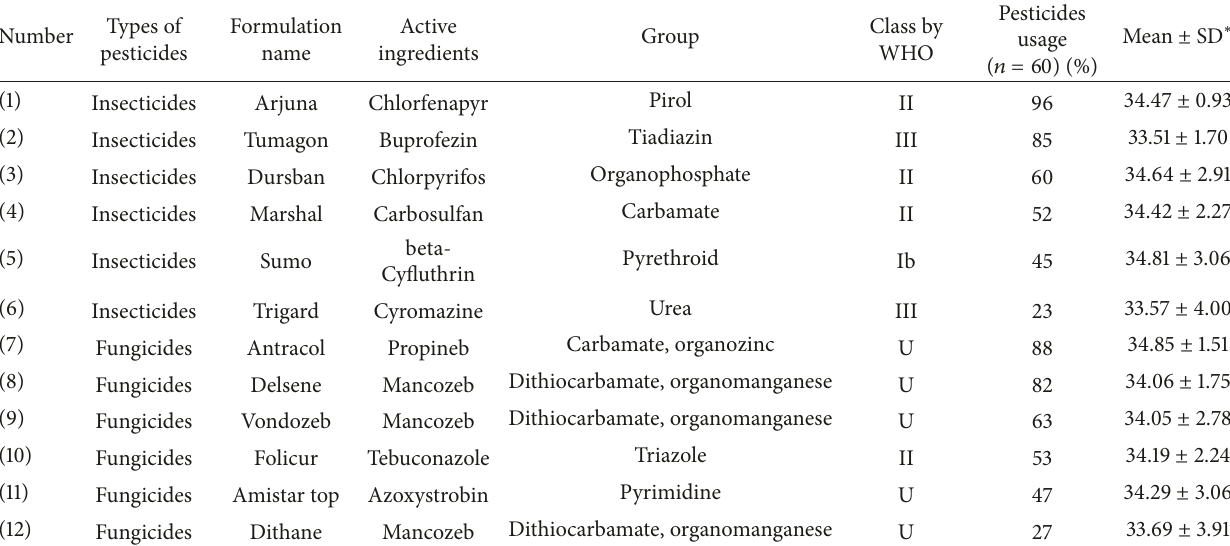
Table 2: List of most insecticides and fungicides previously approved for use on shallot cultivation in Wanasari Subdistrict. Formulation Active Number Types of pesticides name ingredients